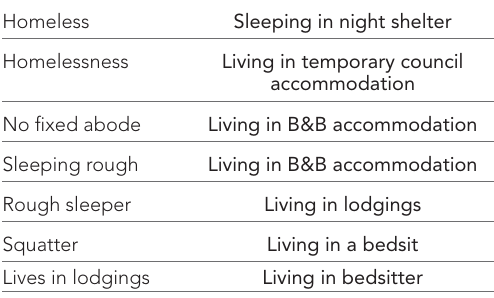
Table 1 . The terminologies were derived through discussion with clinical staff in the study practices, published literature including policy documents,